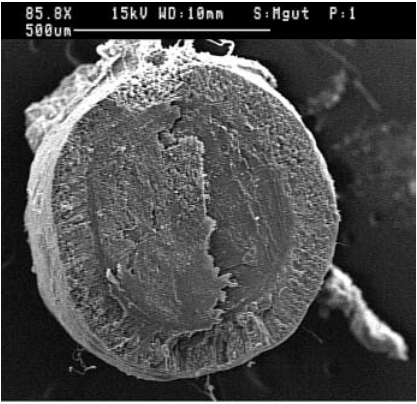
Fig. 7. scanning election micrograph of the hindgut of a fourth-instar